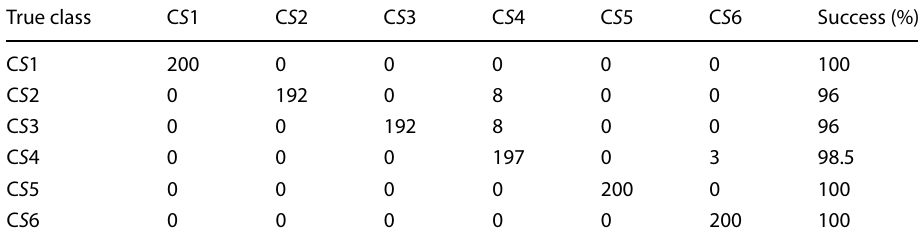
Table 9 Confusion matrix of testing data of conventional ELM